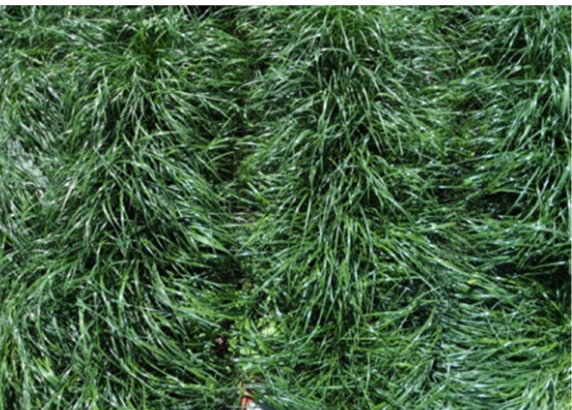
Figure 5. Perennial ryegrass ( Lolium perenne L.) Variety Tetrany. Author’s photos of Prof. A.